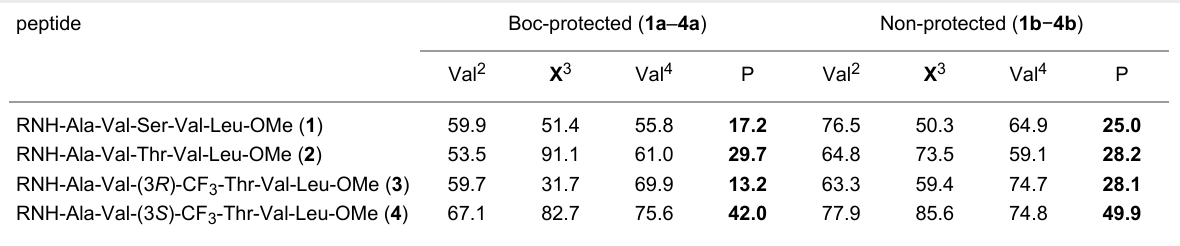
Table 6: Probability (%) of the three central residues of the eight studied peptides to be in β -conformation. The column P indicates the probability for each peptide to have all its three central residues in β -conformation. peptide